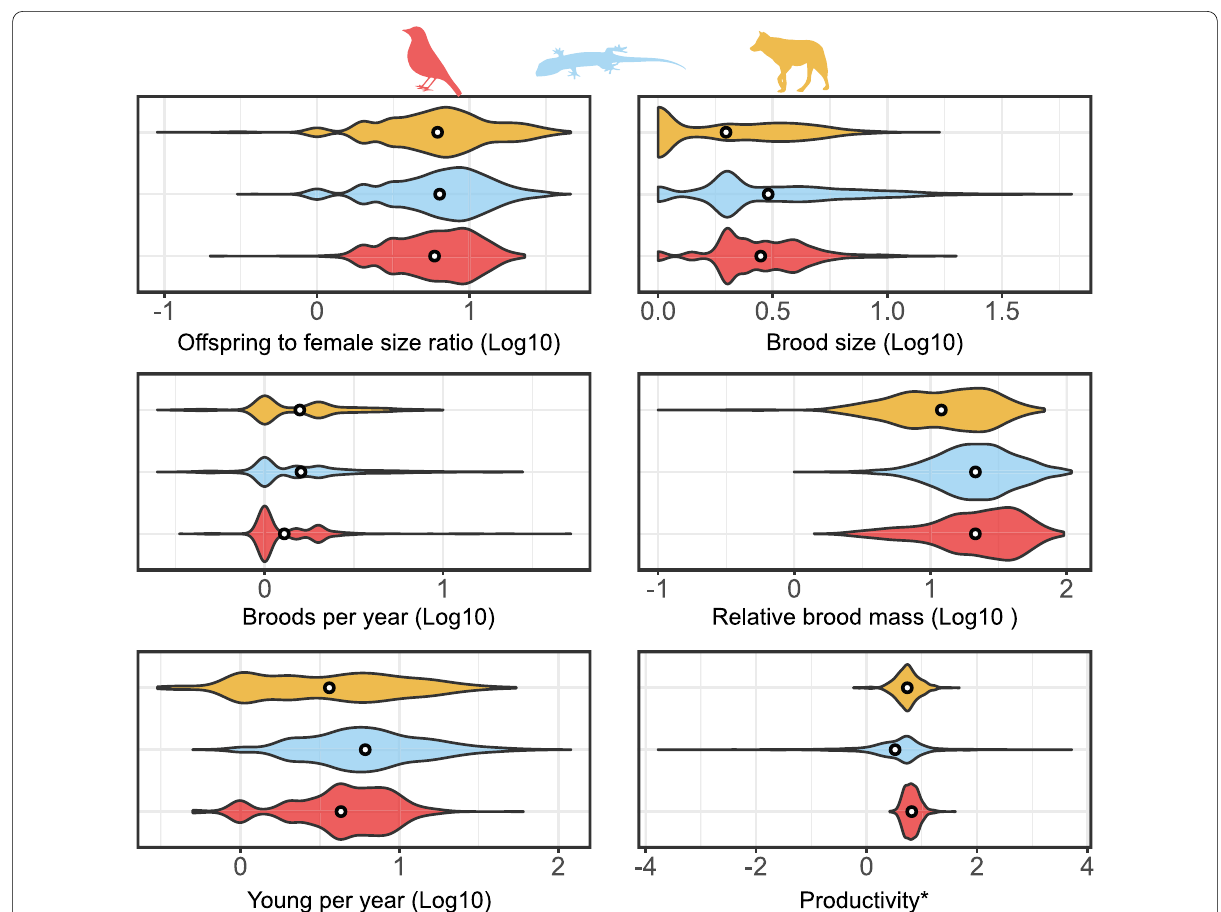
Fig. 14 Violin plots depicting the distribution of life history traits in the three major amniote clades. Means are represented as solid white points. Productivity expressed as the ratio of productivity (brood size